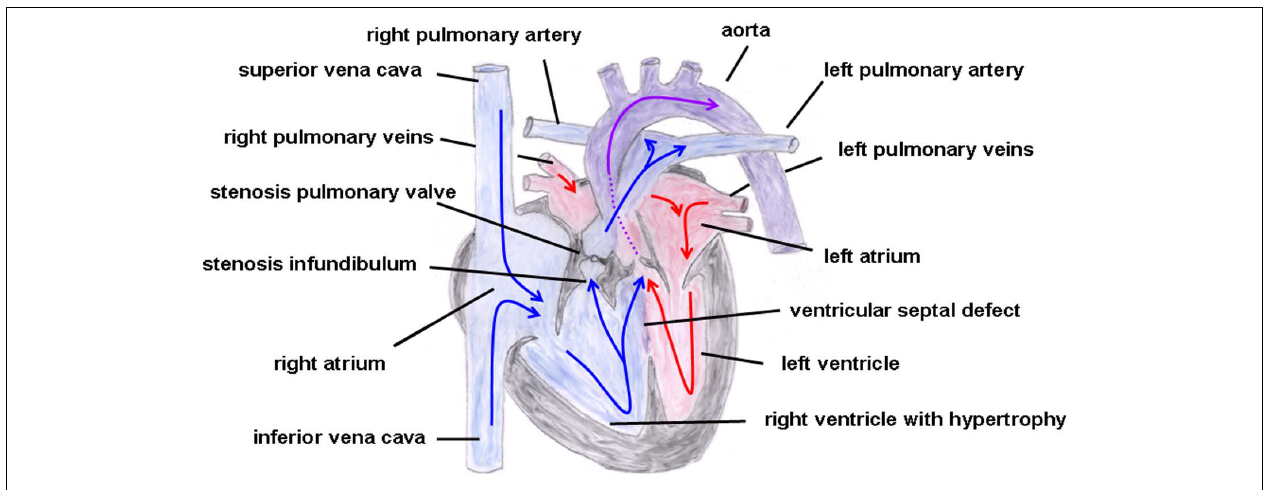
FIGURE 6 |Tetralogy of Fallot. Depicted are the four cardiac malformations described by Fallot: (1) right ventricular hypertrophy, (2) pulmonary stenosis (valvular and infundibular), (3) ventricular septal defect with (4) overriding of the aortic root.The blue arrows give the flow of oxygen-poor blood from both